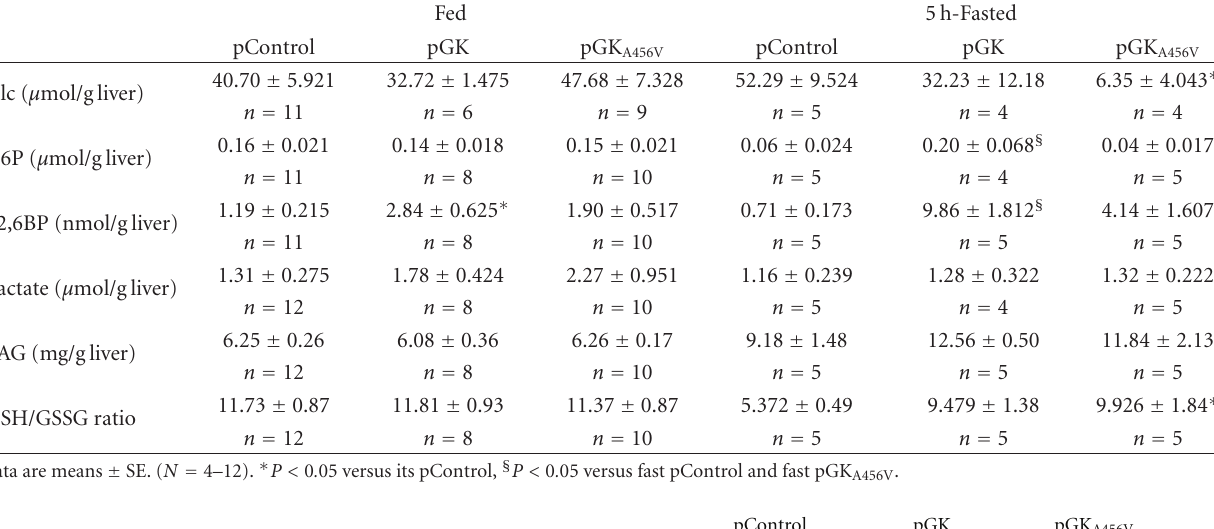
Table 1: Liver metabolites of STZ-diabetic mice transfected with pControl, pGK and pGK A456V .